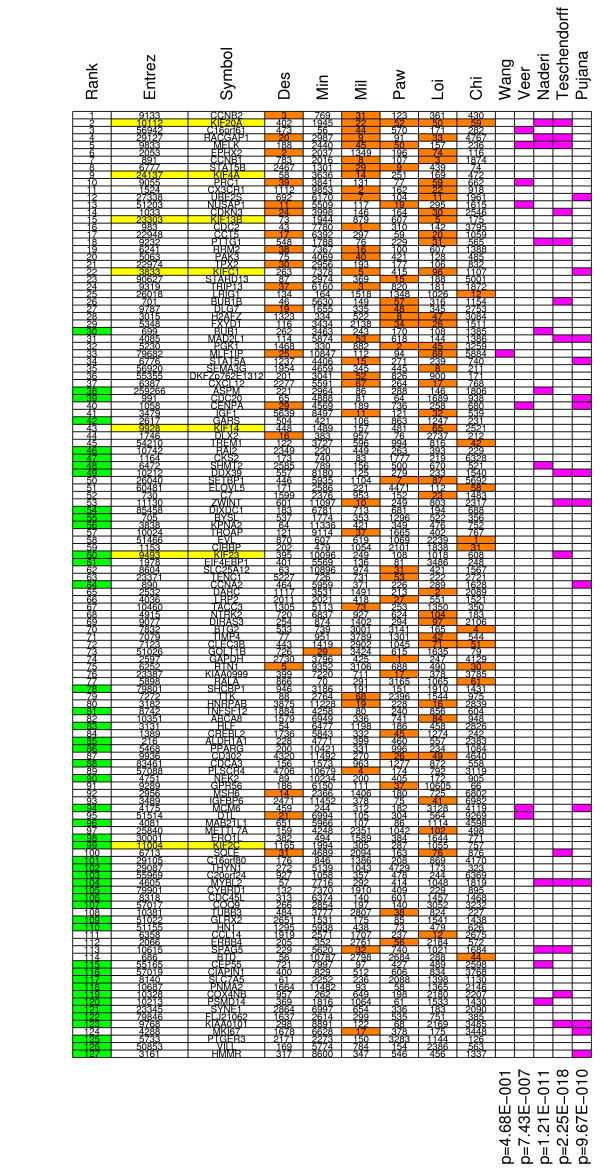
Chart listing the 127 genes selected in the classifier trained on all six datasets. For each gene, we list the rank, Entrez id, and Gene symbol. Green cell shading indicates the genes that are part of the signature from the six pooled datasets, which are not part of any of the signatures from the single datasets. Yellow cell shading indicates the seven microtubule associated genes. The succeeding columns indicate the rank position of a particular gene in each of the six separate rankings. An orange cell shading indicates the genes that were part of the individual signatures. The purple cell shading indicates the overlap to a group of existing breast cancer signatures (Wang et al. [2], Vijver et al. [3], Naderi et al. [19], Teschendorff et al. [20]), and a group of breast cancer associated genes (Pujana et al. [29]). P-values indicating the significance of the overlap (hypergeometric test) of these signatures is given at the bottom of the columns.